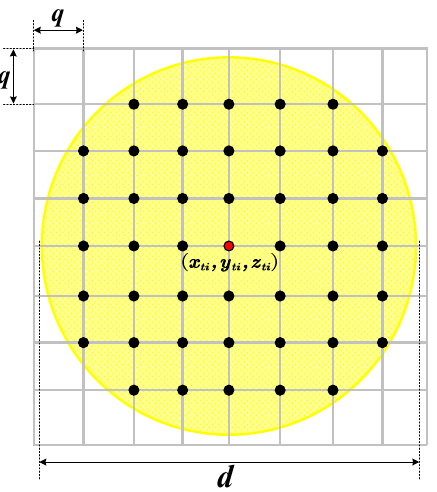
Figure 6. Mesh nodes inside the pulse spot.